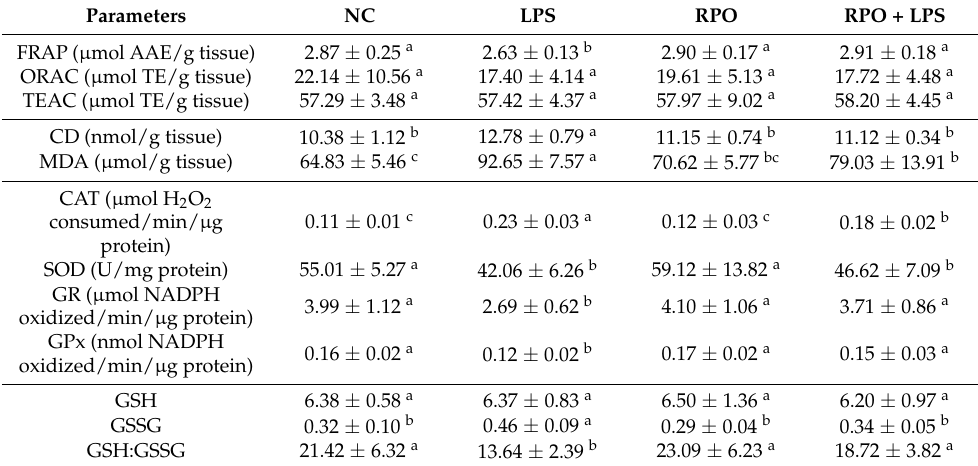
Table 4. Effects of dietary RPO consumption on hepatic antioxidant capacity, lipid peroxidation, antioxidant enzymes activity and glutathione redox status in LPS-induced endotoxemic